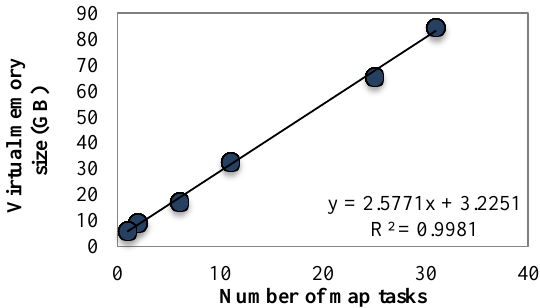
Figure 10. Number of map tasks versus virtual memory size